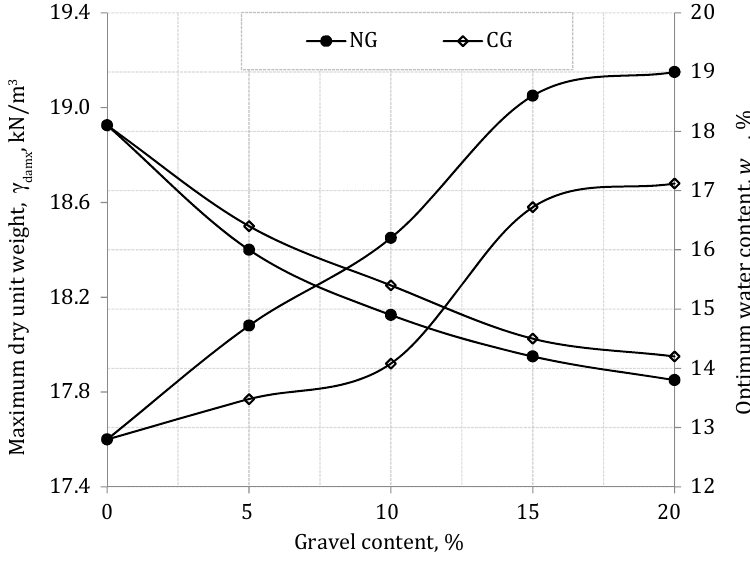
Figure 4. g dmax and w opt values for clay containing different gravel